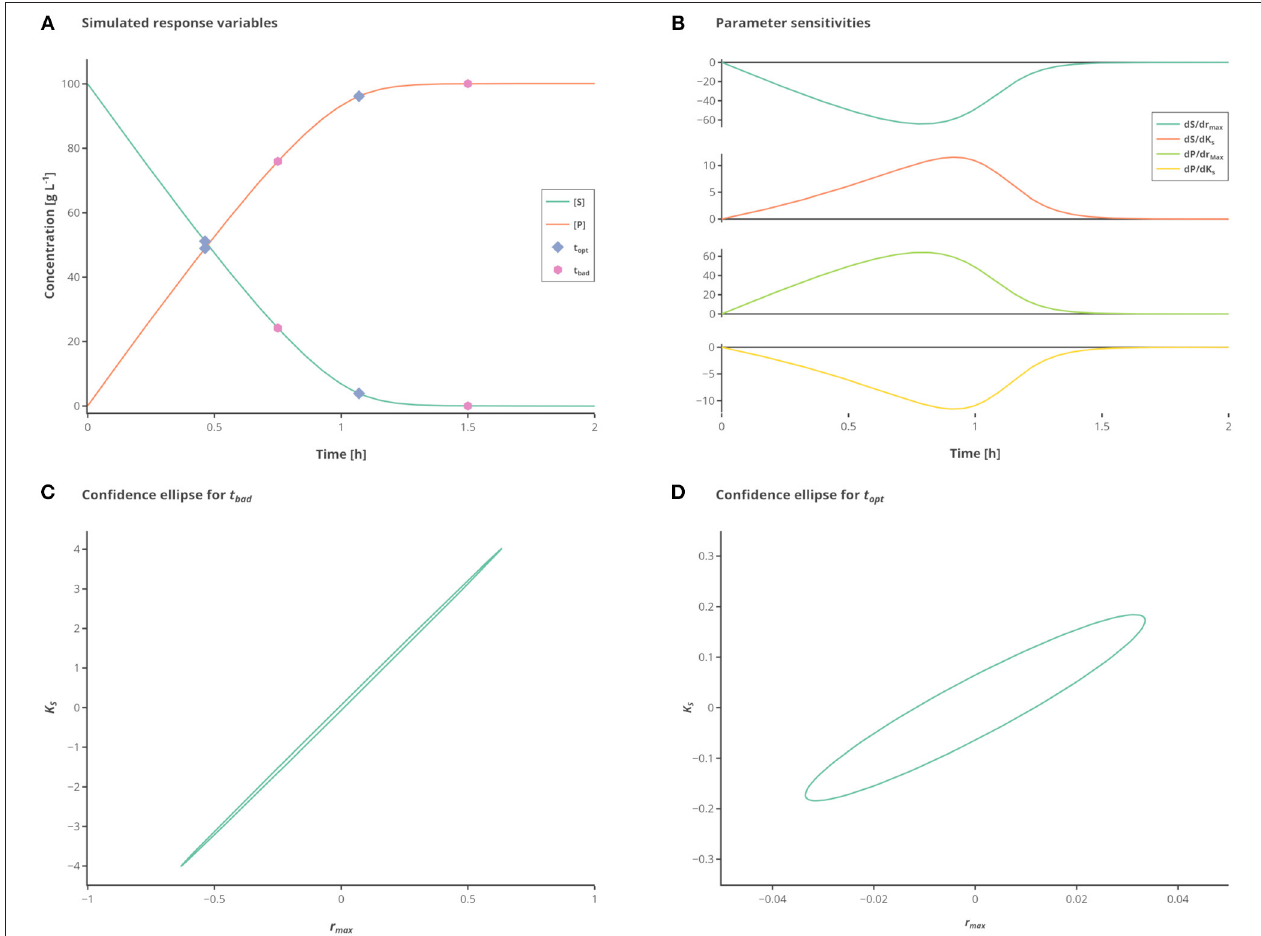
FIGURE 1 | Influence of different measurement time points. (A) Simulated state variables. The state variables substrate ( S ) (green line) and product ( P ) (orange line) as well as the best (hexagon) and standard (circles) measurement points are shown over time. (B) Sensitivities of the state variables to the respective parameters. (C) Confidence ellipse for the unoptimized (“standard”) measurements. (D) Confidence ellipse for optimized (“best”) measurements. Interactive versions of these plots can be found at: